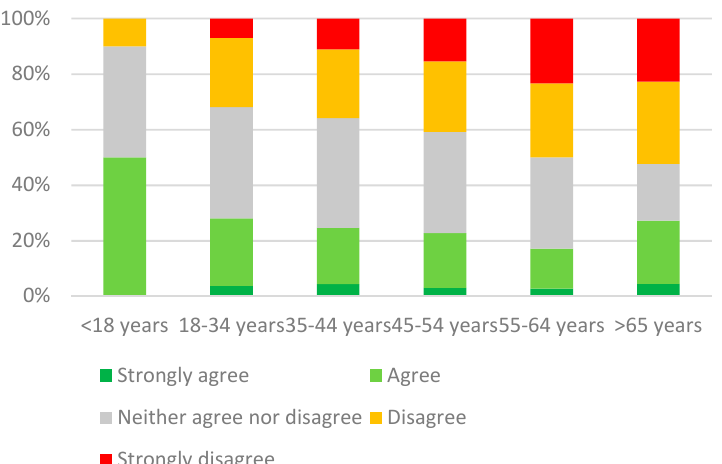
Figure 1. Degree of agreement for each age bracket with the statement: “the use of preservatives in pet food is necessary for optimal preservation”.